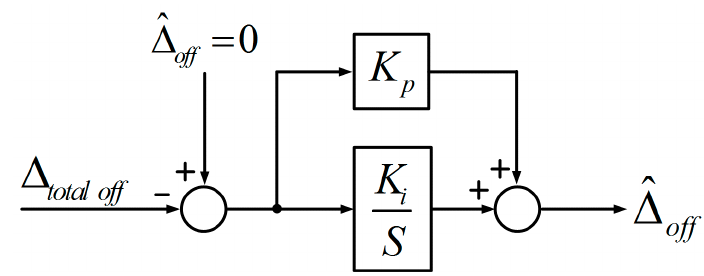
Figure 5. Block diagram of the PI controller to estimate Δ ˆ